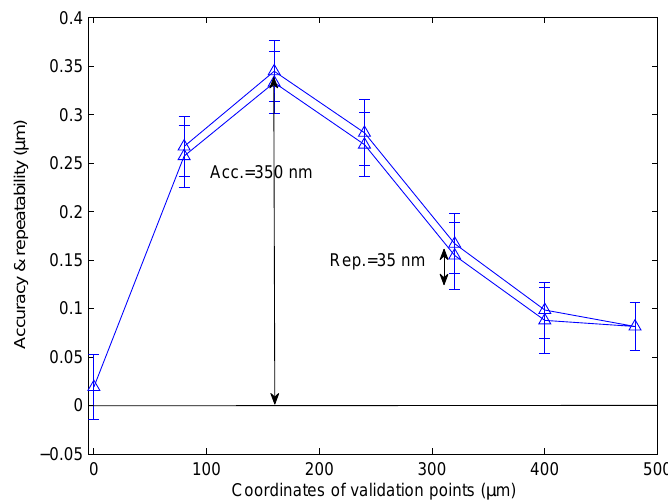
Figure 10. Accuracy of the nanopositioning stage in a controlled environment.